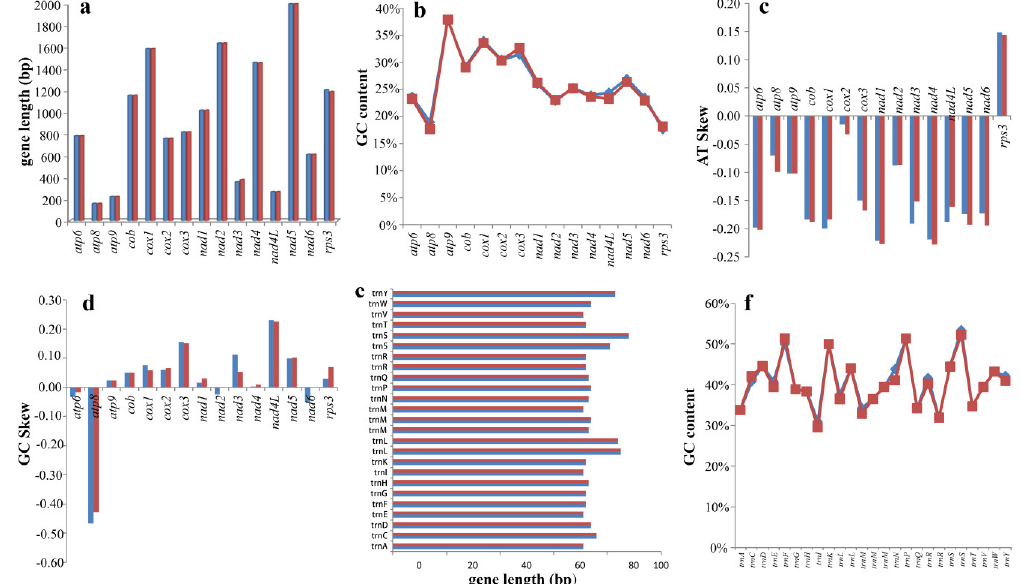
Figure 5. Variation in the length and base composition of each of 15 protein-coding genes (PCGs) and 25 tRNA genes between two Rhizopogon mitogenomes. R. salebrosus is represented in blue and R. vinicolor is represented in red. ( a ) PCG length variation; ( b ) GC content of the PCGs; ( c ) AT skew; ( d ) GC skew; ( e ) lengths of shared tRNA genes; ( f ) GC content of shared tRNA genes. Among the 15 core PCGs detected, rps3 gene had the largest K2P genetic distance between the two Rhizopogon species, followed by nad6 gene (Figure 6). The K2P genetic distance of atp9 gene between two Rhizopogon species was the smallest, indicating that it was highly conserved between Rhizopogon species. The cox3 gene had the largest synonymous substitutions rate (Ks) among the 15 core PCGs, while atp9 had the smallest Ks value. The nonsynonymous substitution rate (Ka) of atp8 gene was 0, while that of rps3 gene was the largest in the Rhizopogon species. The Ka/Ks values of the 15 core PCGs ranged from 0 to 0.69, indicating that these genes were subjected to purifying selection.